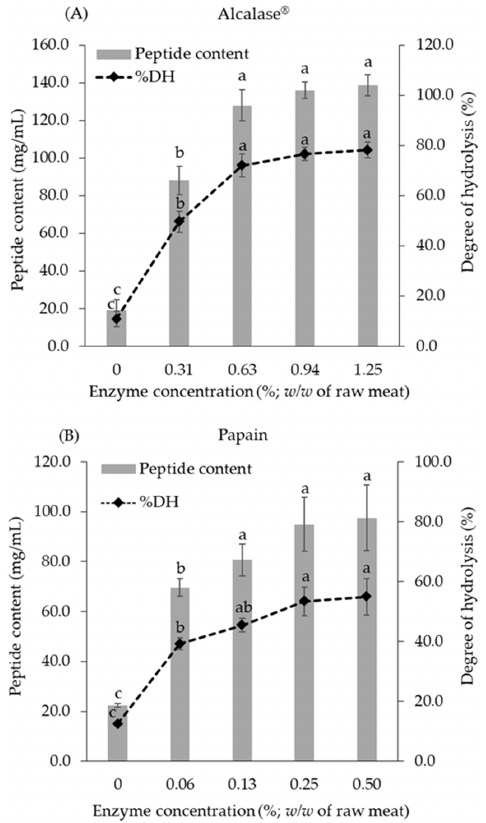
Figure 1. Effects of enzyme concentration on degree of hydrolysis (DH) and peptide content in chicken meat hydrolysates. ( A ): Alcalase ® and ( B ): papain. Different letters in the bar graph indicate significant differences at p < 0.05.